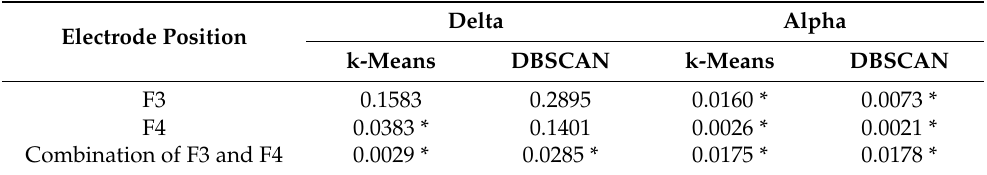
Table 6. The p -value of Wilcoxon signed-rank test for the mean delta and mean alpha power at respective electrode position. Delta Alpha Electrode Position k-Means DBSCAN k-Means DBSCAN F3 0.1583 0.2895 0.0160 * 0.0073 * F4 0.0383 * 0.1401 0.0026 * 0.0021 * Combination of F3 and F4 0.0029 * 0.0285 * 0.0175